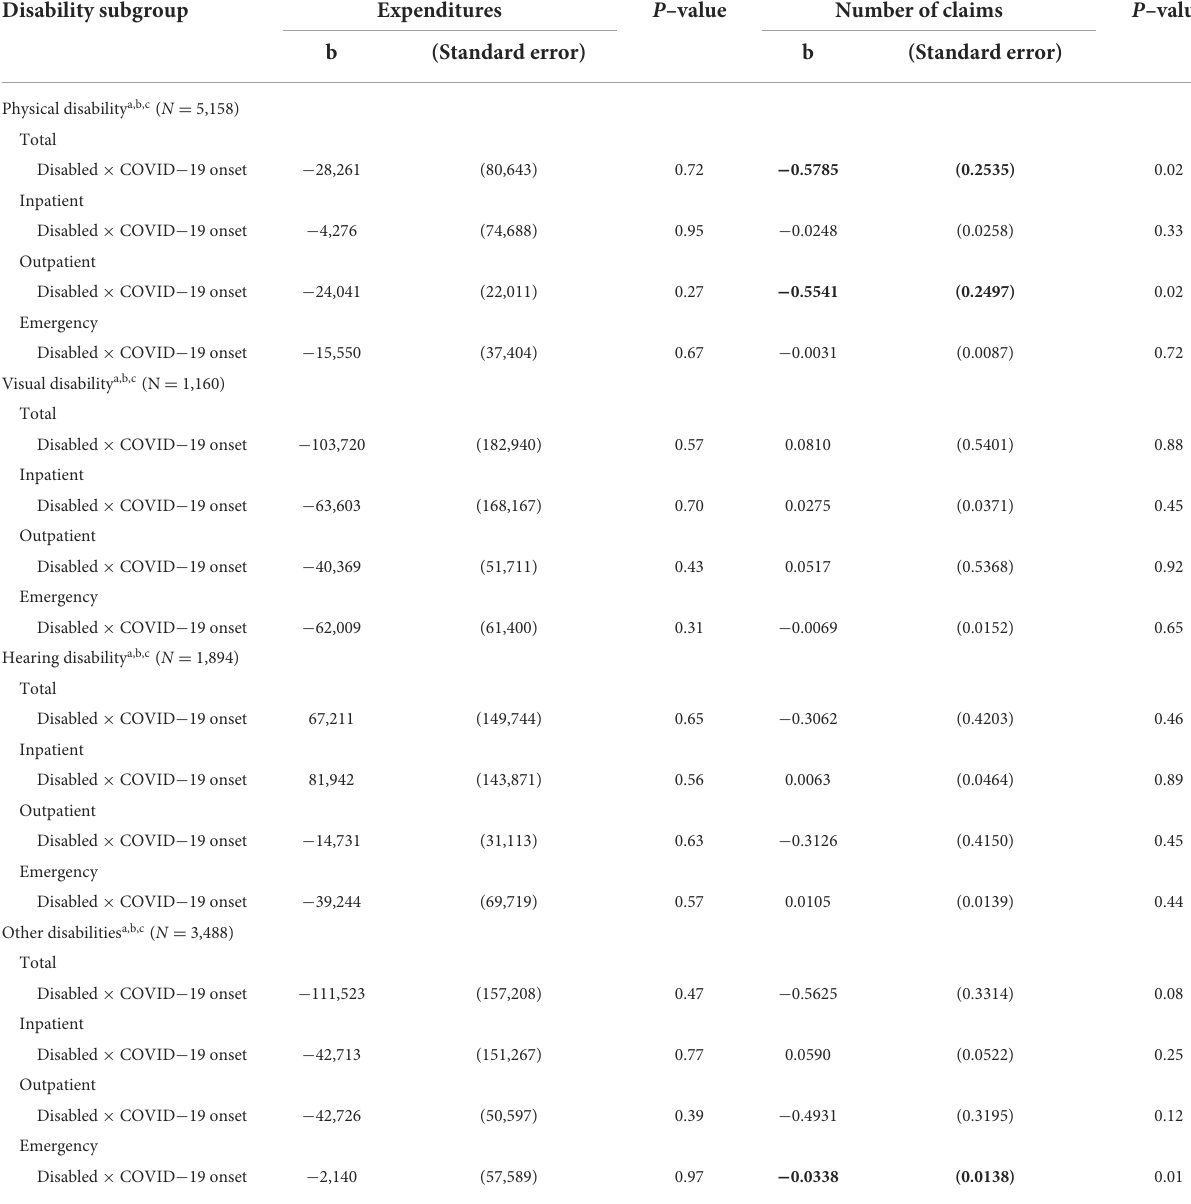
TABLE 4 Multivariate random–effects regression of the incremental change in healthcare service utilization in early COVID − 19 pandemic compared to pre–pandemic period by disability type d